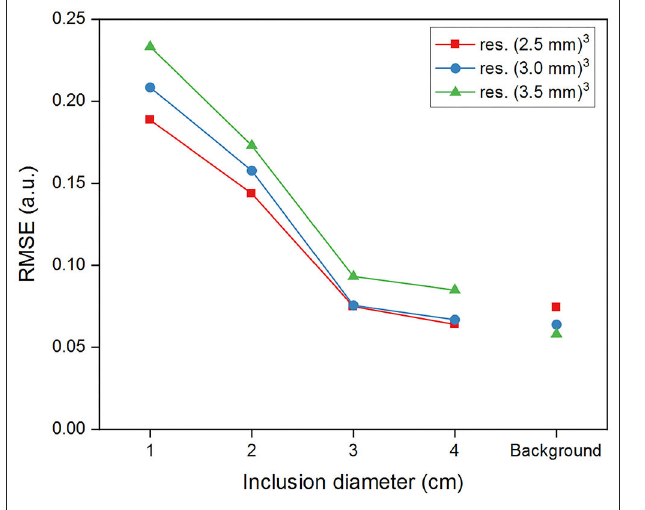
FIGURE 4 | Root-mean-square-error (RMSE) of G’ reconstructed within the inclusions and in the background for the simulated data and for the different spatial resolutions.